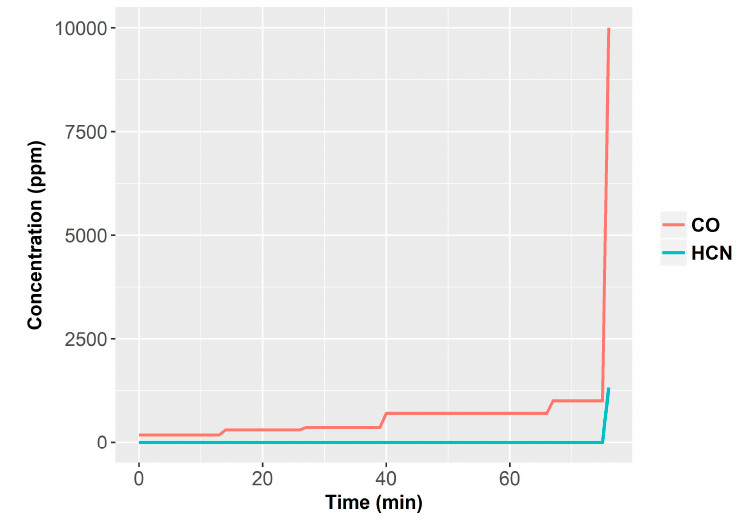
Figure 1. Example of evolution of CO and HCN for a smoldering fire (NIST tests) [40]. Sensors 2018 , 18 , x FOR PEER REVIEW